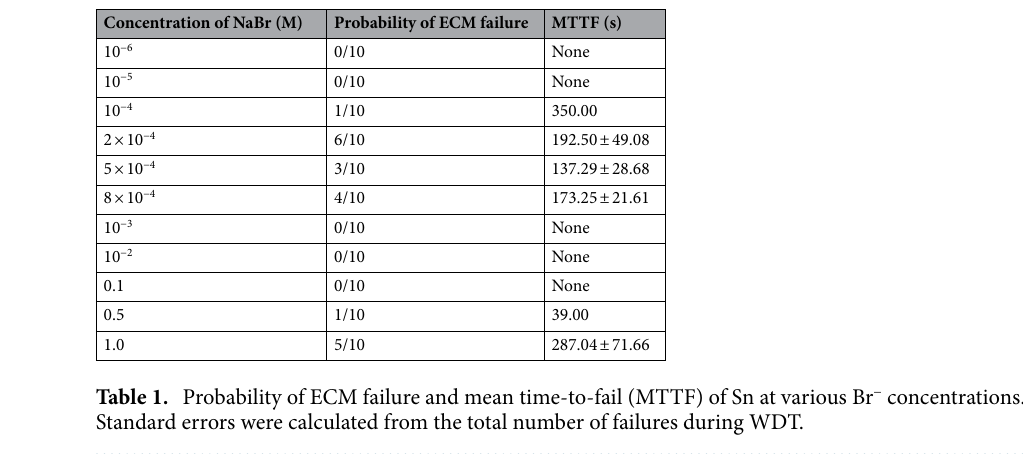
Polarization curves. Figure 7a shows the polarization curves of pure Sn in solutions containing various concentrations of Br − ions (10 −6 M–1.0 M) recorded at the ambient temperature. The values of E corr and I corr were calculated from the Tafel plots obtained from Fig. 7a. The E pitt was also obtained from Fig. 7a from the onset of breakdown potential of the passivation. Figure 7b shows the relationship between the concentration of Br − and the electrochemical parameters such as E corr , E pitt and I corr . Generally, the E corr and E pitt decrease while the I corr increases with the Br − concentration.